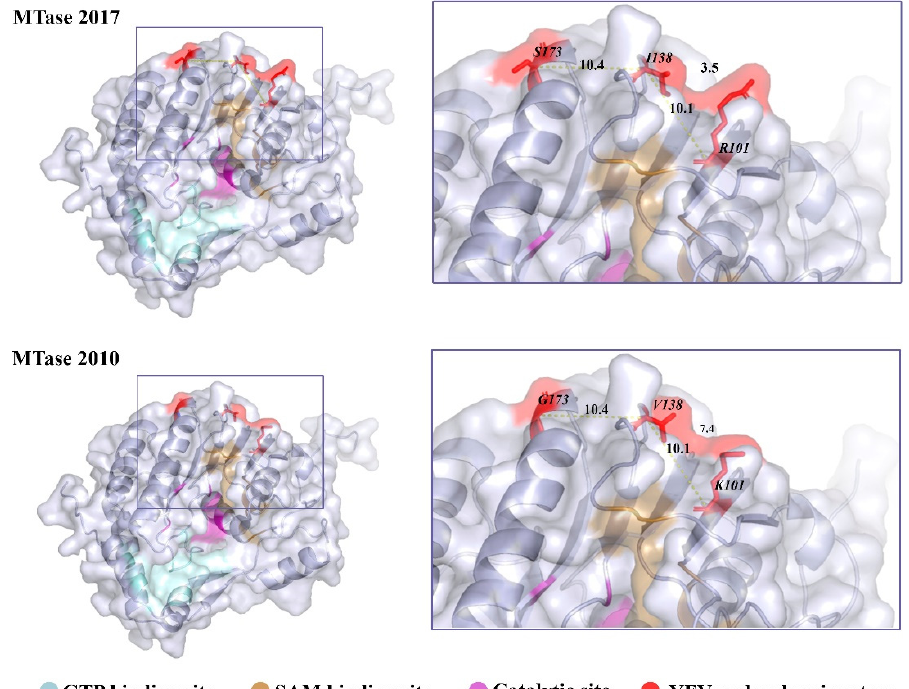
Figure 1. Localization of the YFV 2016 − 2019 molecular signature in the NS5 MTase domain. The MTase domain of the NS5 was modeled by homology based on the sequence of YFV isolate ES-504 (GenBank: KY885000) and on the crystallographic data of YFV 17D MTase (PDB: 3EVB), MTase 2017. Mutations were inserted in PyMOL, generating MTase 2010. The models are represented in the cartoon with their respective molecular surfaces. GTP (blue) and SAM (pale yellow) binding sites are highlighted, as well as the catalytic site (purple) responsible for the methyl transfer reactions and the residues that compose the YFV 2016 − 2019 molecular